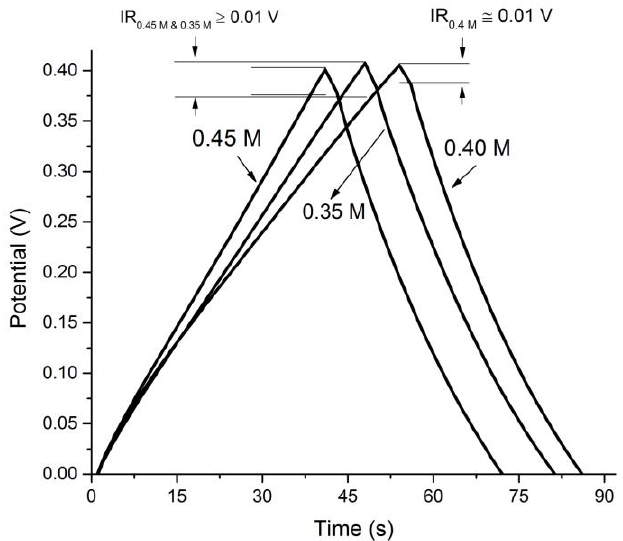
Figure 5: Galvanostatic charge-discharge curves of PANI based redox capacitors with different aniline